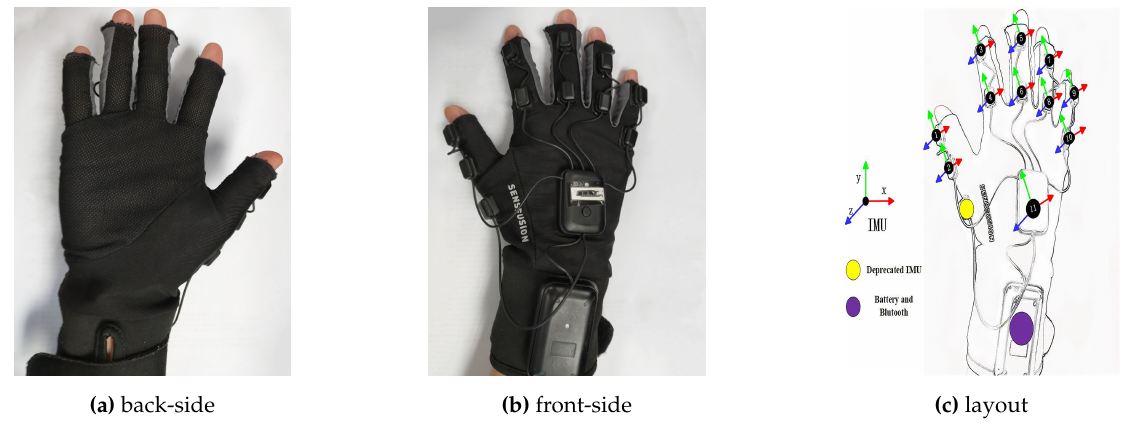
Figure 5. Data glove. ( a ) The back side of the data glove. ( b ) The front side of the data glove. ( c ) The location of inertial measurement units (IMUs) on the hand. We attach 11 IMUs on the glove made by breathable textile lining. Two IMUs on the distal, medial phalange of thumb; two IMUs on the medial, proximal phalanges of each of the other fingers; one IMU on the back of the